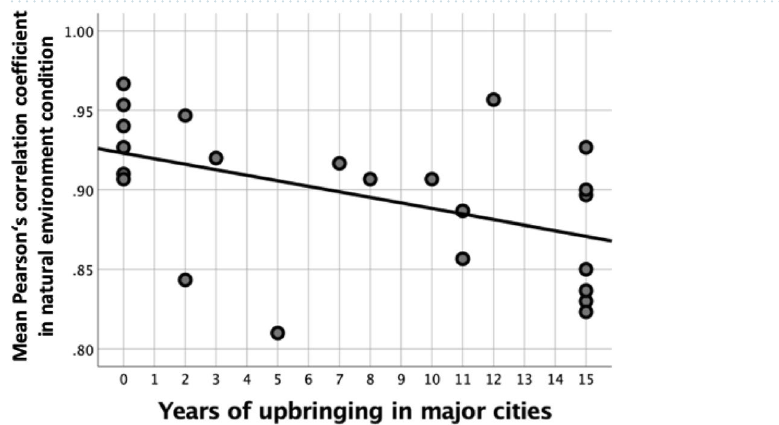
Figure 4. Scatterplots depicting the negative association between mean network connectivity (see Fig. 3) and years of upbringing in major